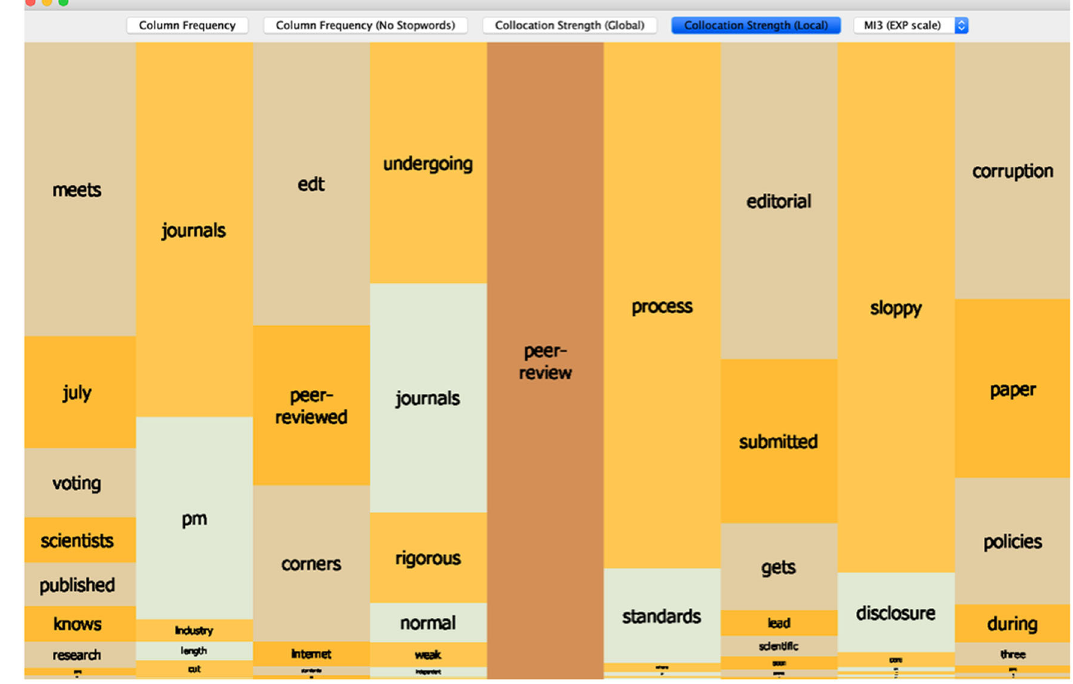
Fig. 8 Mosaic visualization of peer review in CSBC-ACC (12 lines). Collocation strength: Local, MI3 (EXP